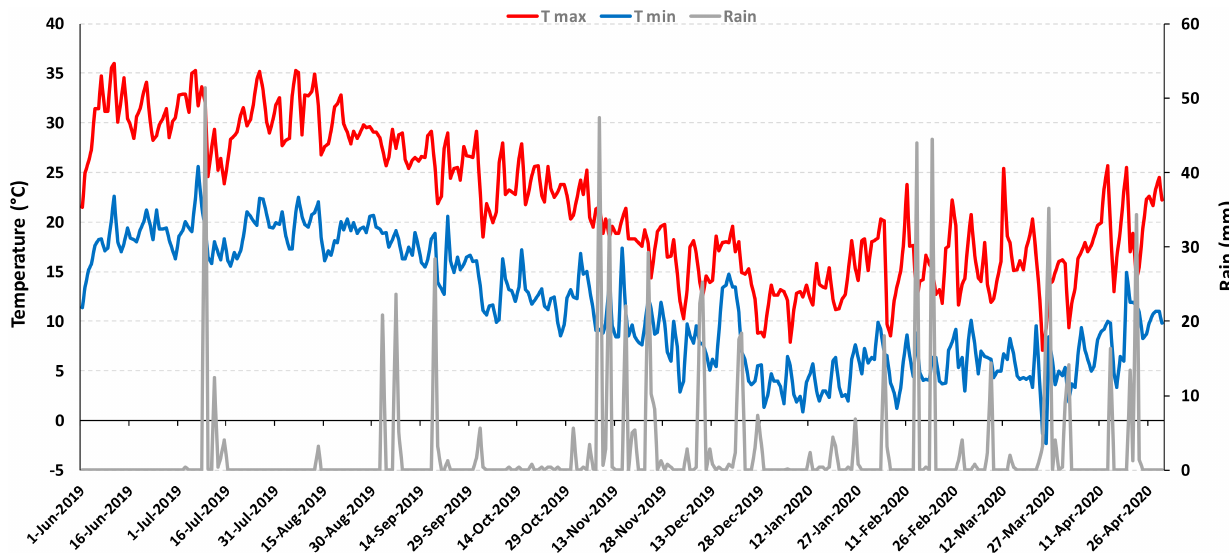
Figure 6. Daily temperatures (min and max) and rain during the growing cycle (from 1 June 2019 to 30 April 2020). Data retrieved from Dati in telemisura Rete ASSOCODIPUGLIA . Location of weather station: 40 ◦ 10 (cid:48) N, 16 ◦ 58 (cid:48)